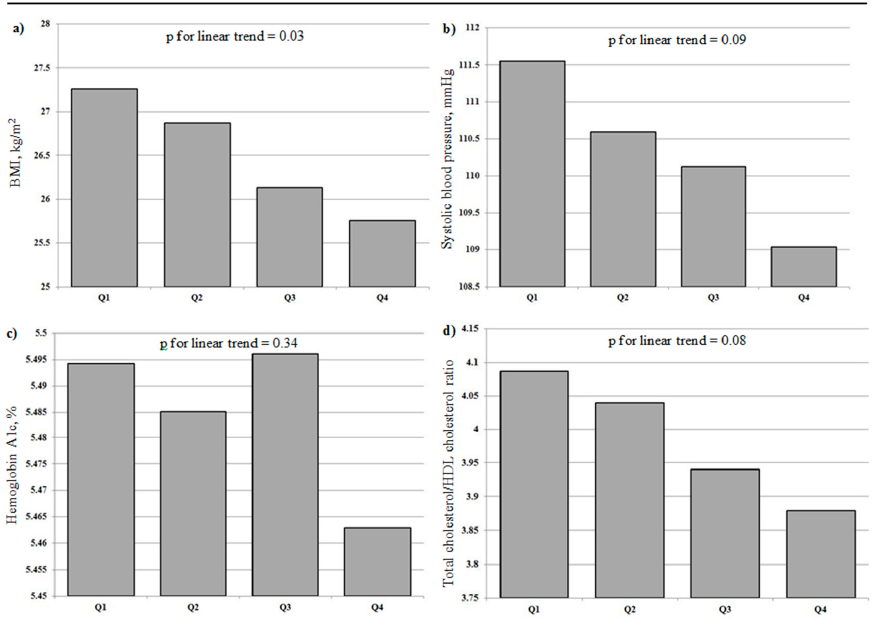
Figure 1. Mean levels of the cardiometabolic health markers of interest across quartiles of an index of neighborhood active-living friendliness (Q1: lowest neighborhood active-living index quartile; Q4: highest neighborhood active-living index quartile). ( a ) BMI; ( b ) systolic blood pressure; ( c ) hemoglobin A1c; ( d ) total cholesterol/HDL cholesterol ratio. Participants from the Canadian Health Measures Survey